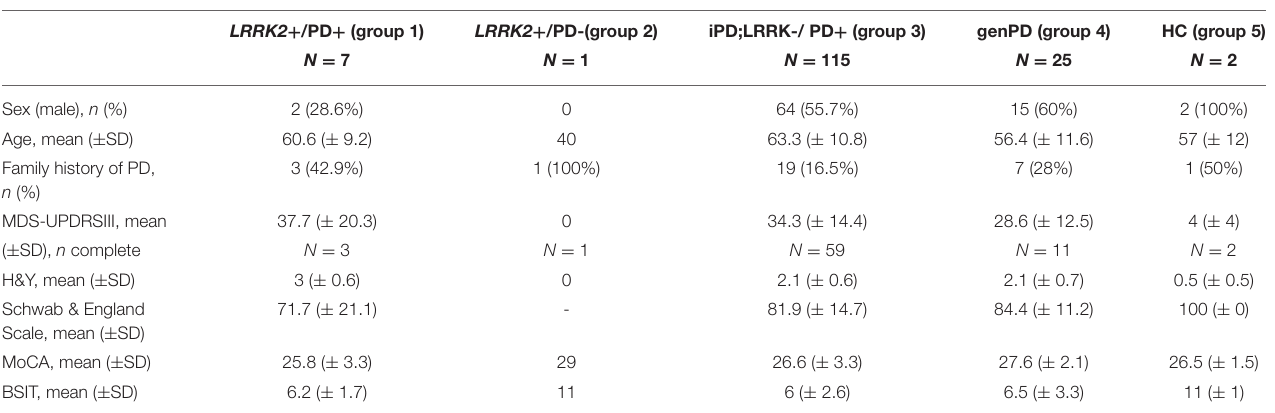
FIGURE 2 | International centers participating in LIPAD. In blue: centers with ethics approval; in black: centers in the process of receiving ethics approval. TABLE 2 | Exemplary demographic and clinical characteristics of the first 150 enrolled LIPAD